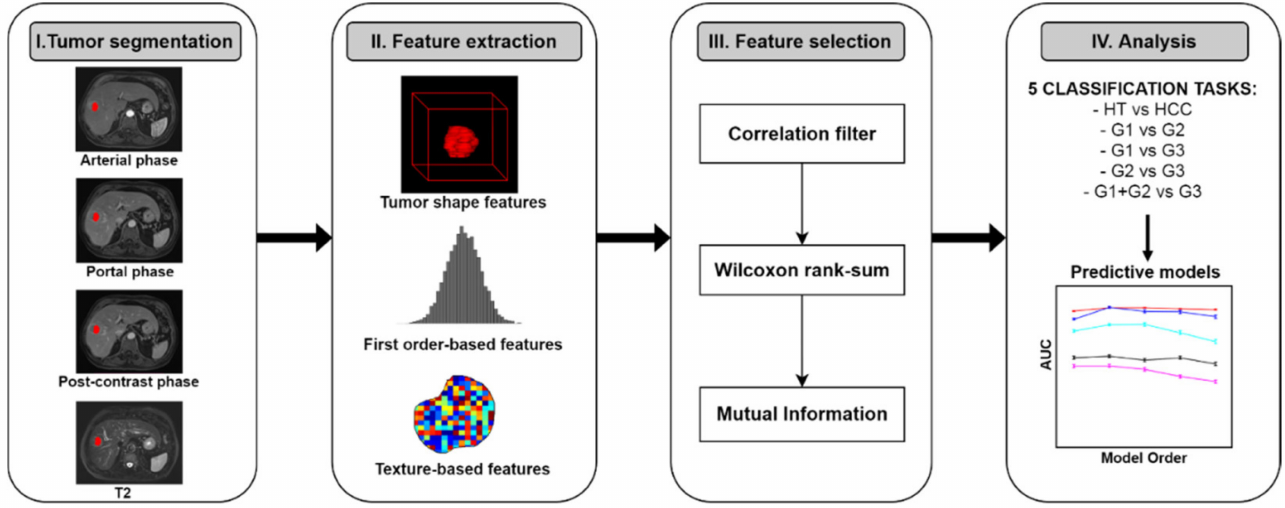
Figure 1. The workflow of radiomics analysis used in this study. Abbreviations: G1, well- differentiated HCC; G2, moderately differentiated HCC; G3, poorly differentiated HCC; AUC, area under the receiver operating characteristic